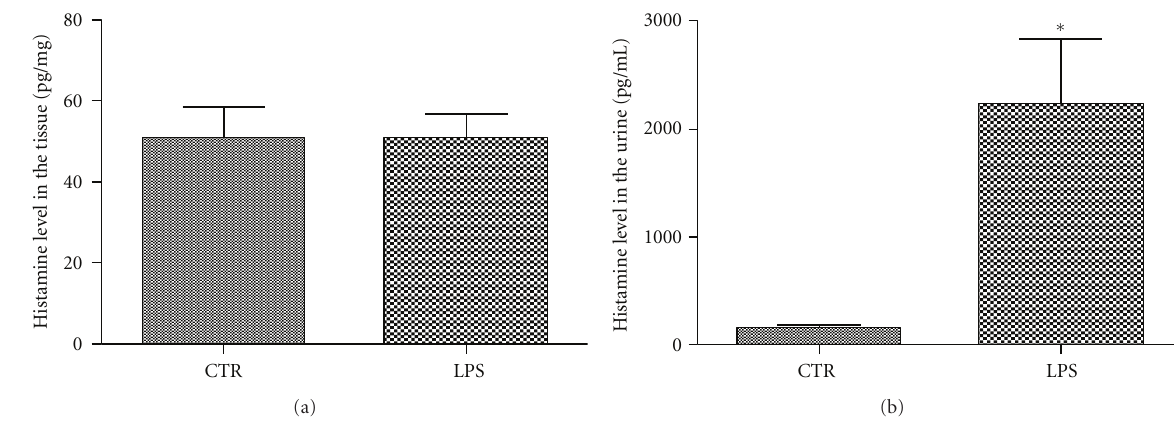
Figure 2: ELISA results for histamine analysis. (a) Histamine levels in bladder tissues of the Model group ( n = 6) show no significant di ff erence with those of the Control group ( n = 3) ( P = 0 . 796). (b) Histamine levels were significantly elevated in urine from the Model group compared with the Control group ( P < 0 .